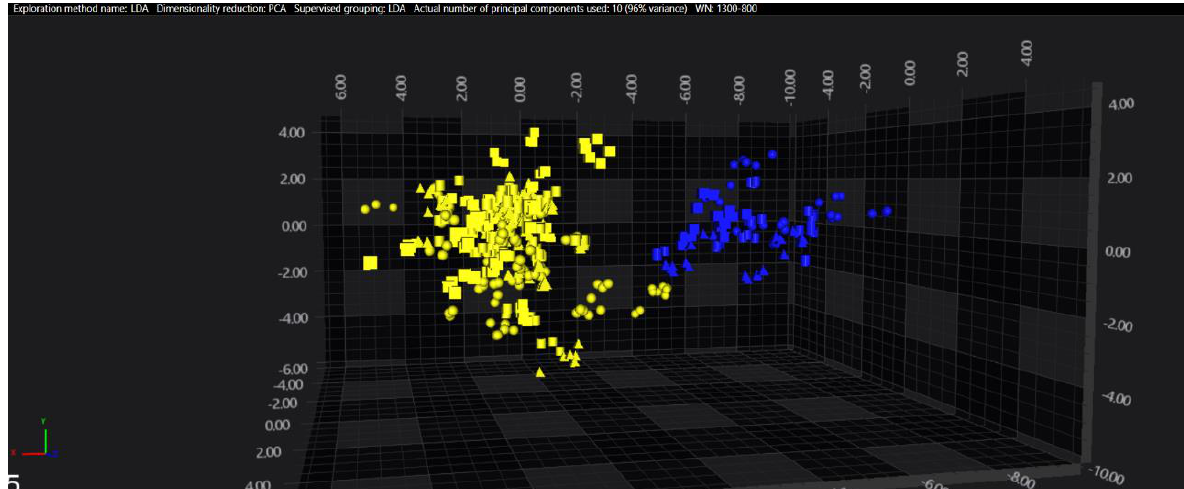
Figure 6. LDA of the O:4 serogroup (blue = Paratyphi B, yellow = other serovars).